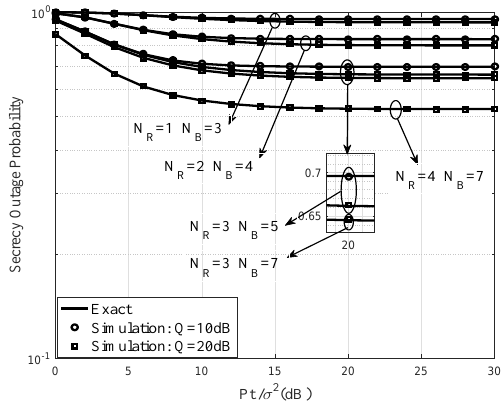
Figure 2. Secrecy outage probability of MRC/MRT-SC scheme for different number N R , N B and Q .